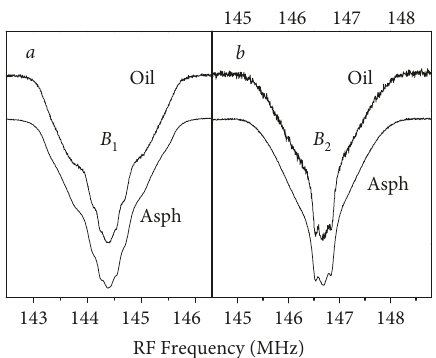
Figure 6: Mims ENDOR for the initial oil and asphaltenes near the proton Larmor frequency measured at (a) B = 3448 9 mT . T = 20 K , B 2 and B in which 1 H 1 2